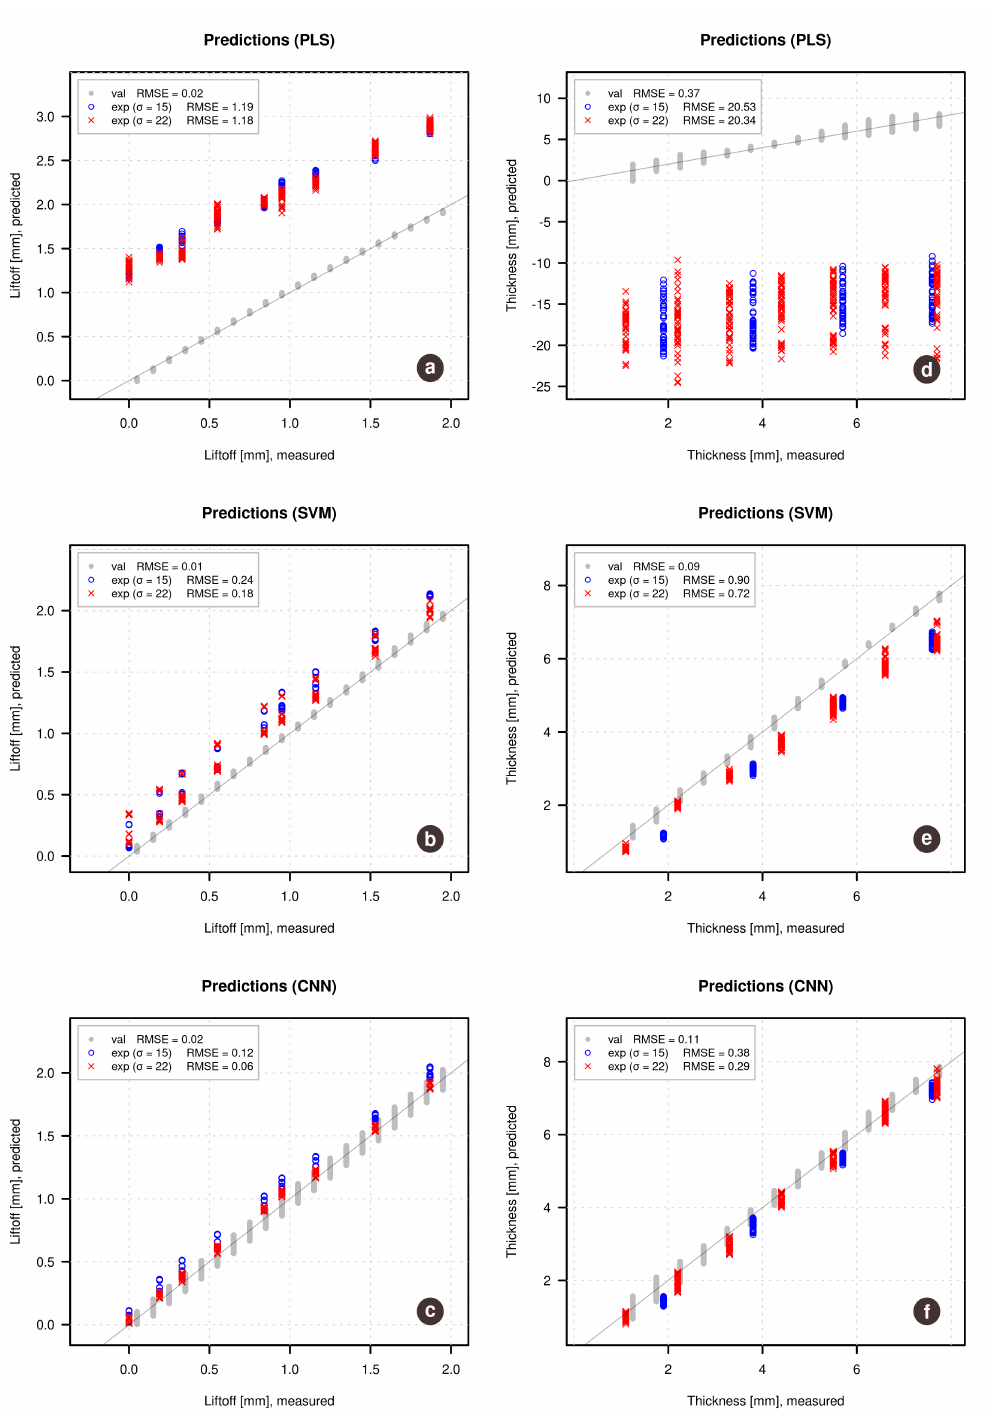
Figure 4. Predicted vs. measured plots for lift-off ( left ) and sample thickness ( right ) obtained using the three regression methods (a,d—PLS; b,e—SVM; c,f—CNN), optimized by the simulated validation set. Gray points show the results for the validation set, red and blue points show the predictions of the experimental